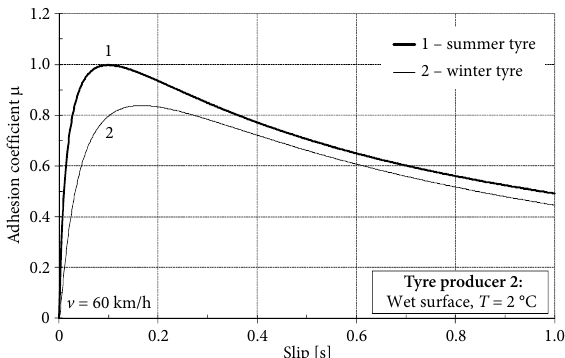
Figure 15. Adhesion characteristics m ( s ) for summer and